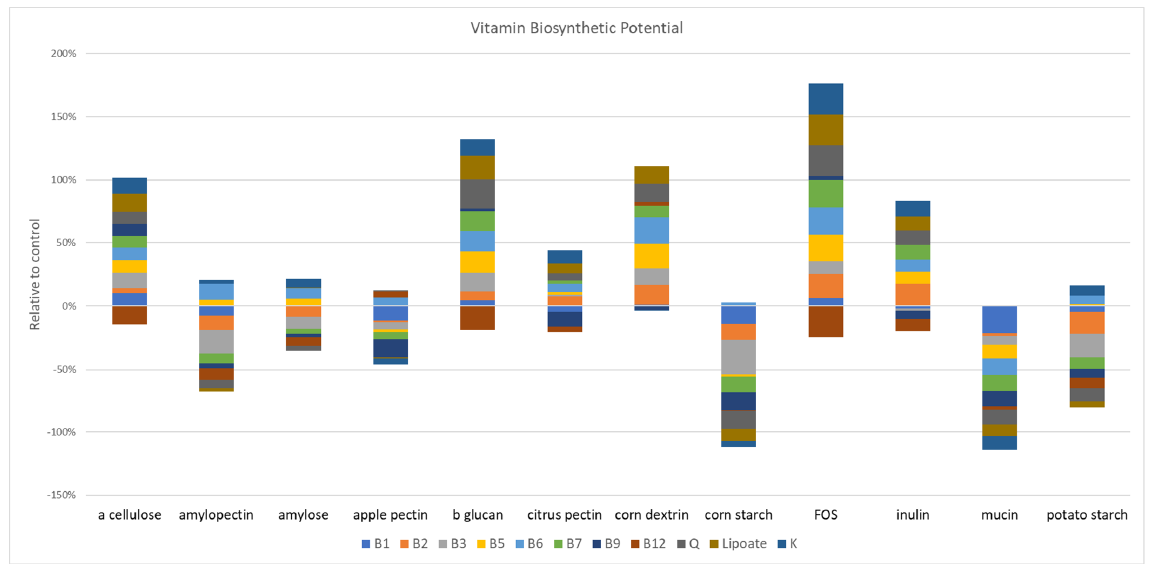
Figure 5. SCFA supplementation alters the representation of vitamin biosynthetic capacity. The impact oof the relative abundance of communities stimulated with prebiotics on the predicted capacity to synthesize vitamins (colored bars).